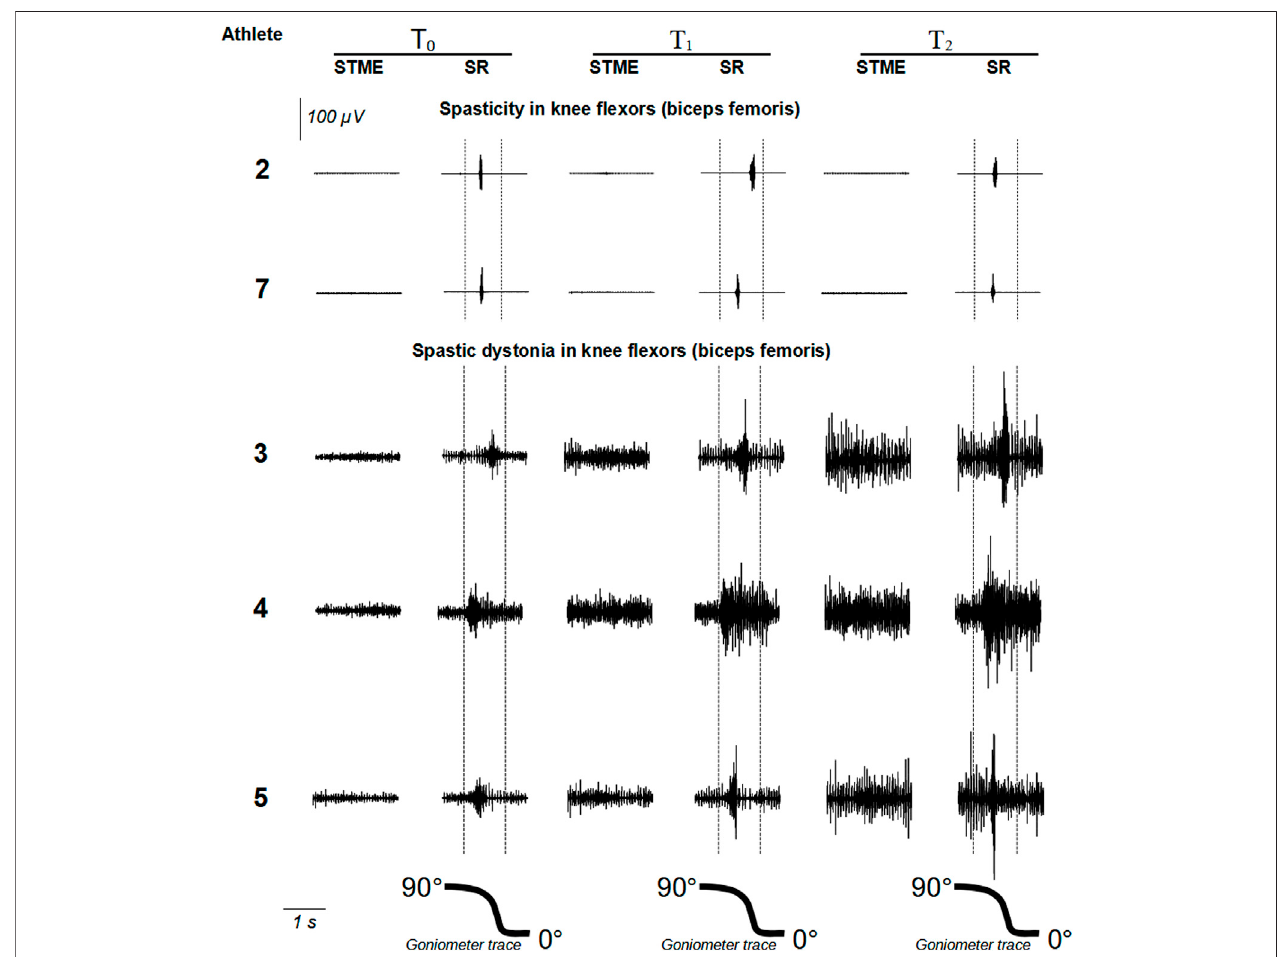
FIGURE 4 | show raw EMG signals from rectus femoris and biceps femoris , respectively. Abbreviations: STME (spontaneous tonic muscle excitation); SR (stretch re fl ex).